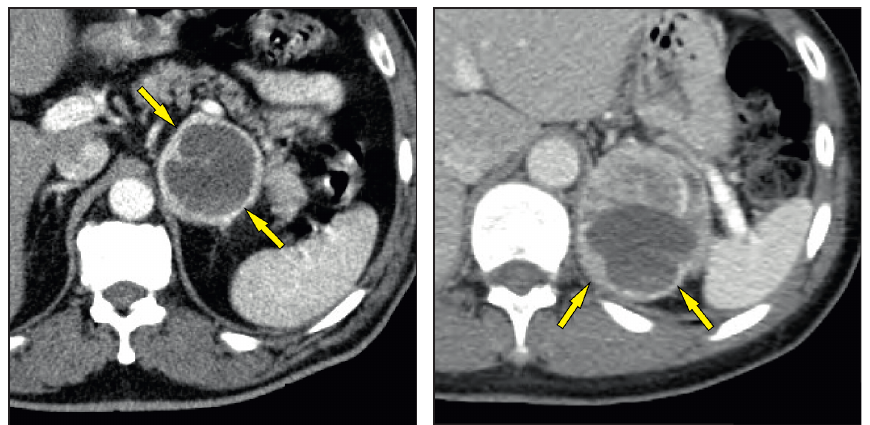
Fig. 4. Partial ring sign. The arrows point to the incomplete enhancing rim around a portion of the surface of a